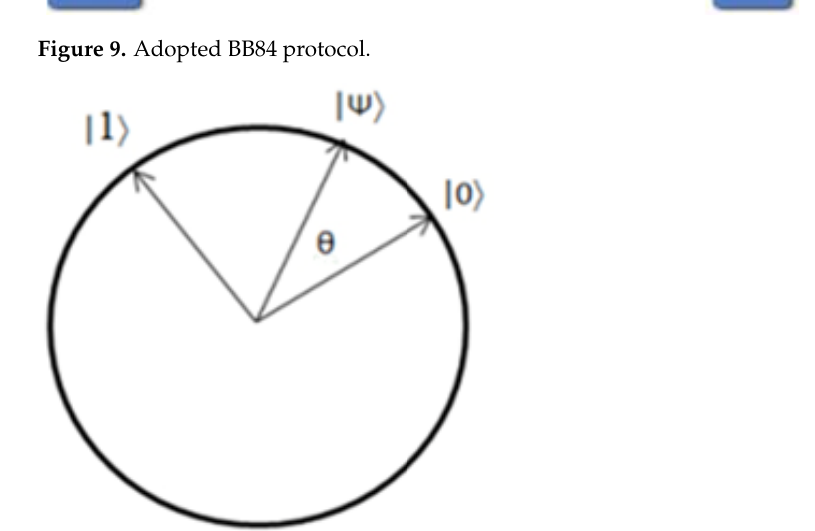
Figure 11. |+ ⟩ and | − ⟩ quantum state. 5. Comparative Discussion Quantum cryptography, based on quantum physics and classical encryption, is a unique concept in cryptography. Quantum cryptography offers security for a variety of applications. Its primary benefits are absolute security and sniffer detection compared to conventional cryptography. These qualities can potentially resolve a significant cyberspace security issue for the future Internet. Personal computers have been developed to a point where those unfamiliar with computer science theory might conclude there is nothing computers cannot do. While this is an understandable conclusion, it has been proven that there is a limit to the types of computation that can be performed by our classical computers, which we today consider general-purpose computers. However, in the last few decades, quantum mechanics and quantum computing have advanced, and primitive operations are now possible in the quantum sphere. Currently, encryption protocols ensure the integrity of data and identities. One such protocol is the widely adopted Diffie – Hellman protocol, an